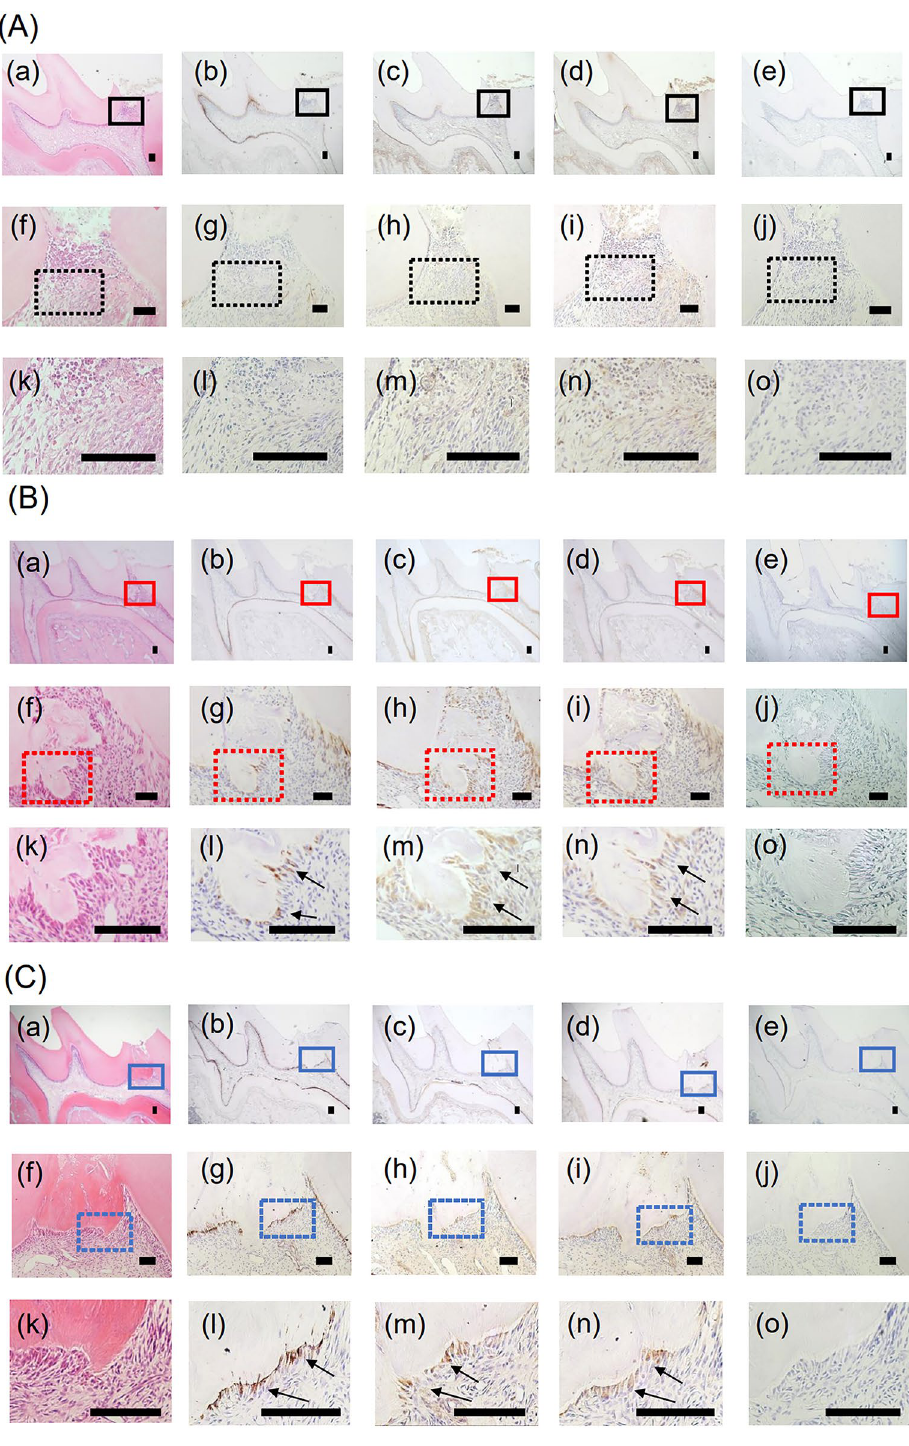
Figure 1. Expression of Th and DA in odontoblast-like cells in rat direct pulp capping model. Images of maxillary first molars at day 3 [ A ( a – o )], day 7 [ B ( a – o )], and day 21 [ C ( a – o )] after direct pulp capping treatment with MTA cement. HE staining of the maxillary first molars [ A ( a , f , k )], [ B ( a , f , k )], [ C ( a , f , k )]. Immunohistochemical staining of the maxillary first molars with anti-Th antibody [ A ( b , g , l ), B ( b , g , l ), C ( b , g , l )], anti-DA antibody [ A ( c , h , m ), B ( c , h , m ), C ( c , h , m )], and anti-Nestin antibody [ A ( d , i , n ), B ( d , i , n ), C ( d , i , n )]. [ A ( f – j )] Magnified images of the black boxed areas in [ A ( a – e )]. [ A ( k – o )] Magnified images of the black dotted boxed areas in [ A ( f – j )]. [ B ( f – j )] Magnified images of the red boxed areas in [ B ( a – e )]. [ B ( k – o )] Magnified images of the red dotted boxed areas in [ B ( f – j )]. [ C ( f – j )] Magnified images of the blue boxed areas in [ C ( a – e )]. [ C ( k – o )] Magnified images of the blue dotted boxed areas in [ C ( f – j )]. [ A ( e , j , o ), B ( e , j , o ), C ( e , j , o )] Rabbit control IgG was used as a negative control. Nuclei were stained with hematoxylin. Bars = 100 μm. Arrows; odontoblast-like